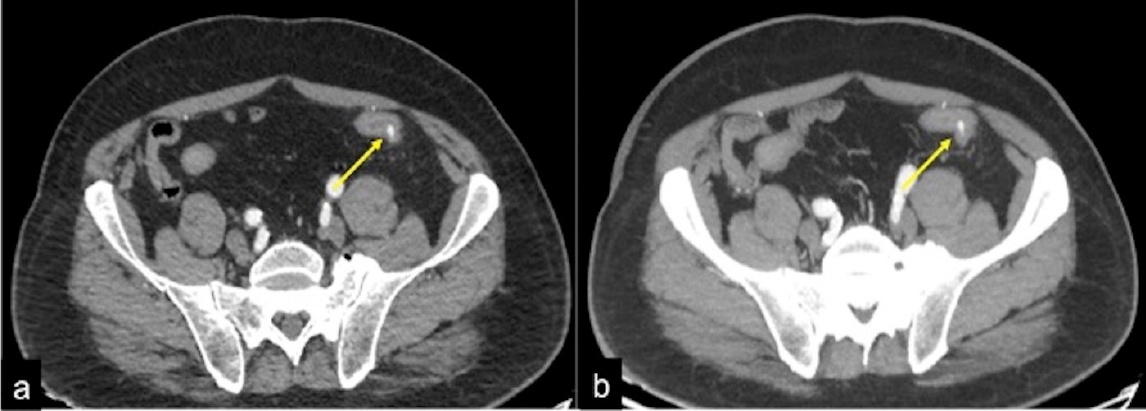
Figure 12. CTA arterial phase ( a ) and relative MIP reconstruction ( b ) of a haemorrhagic spot in the descending colon. ( a , b , arrow)